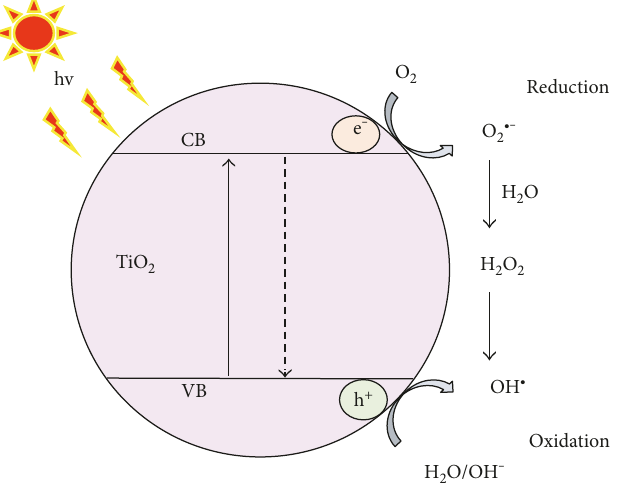
Scheme 1: Schematic representation of the photocatalysis